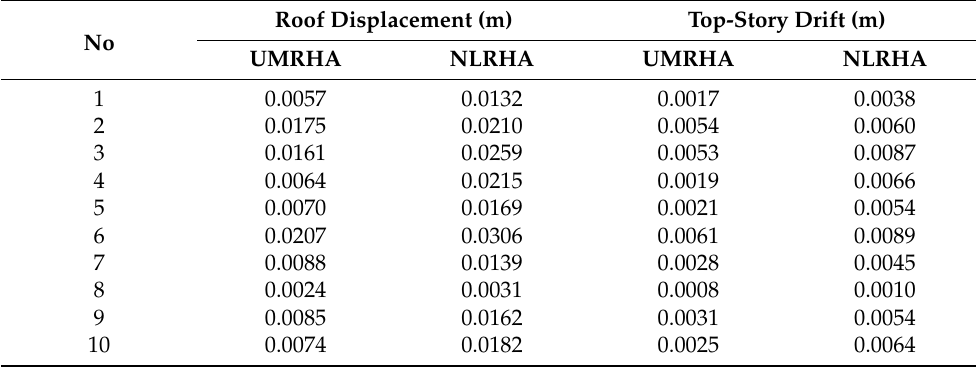
Table 9. Peak values regarding roof displacement and top-story drift of RES original frame to the selected ground